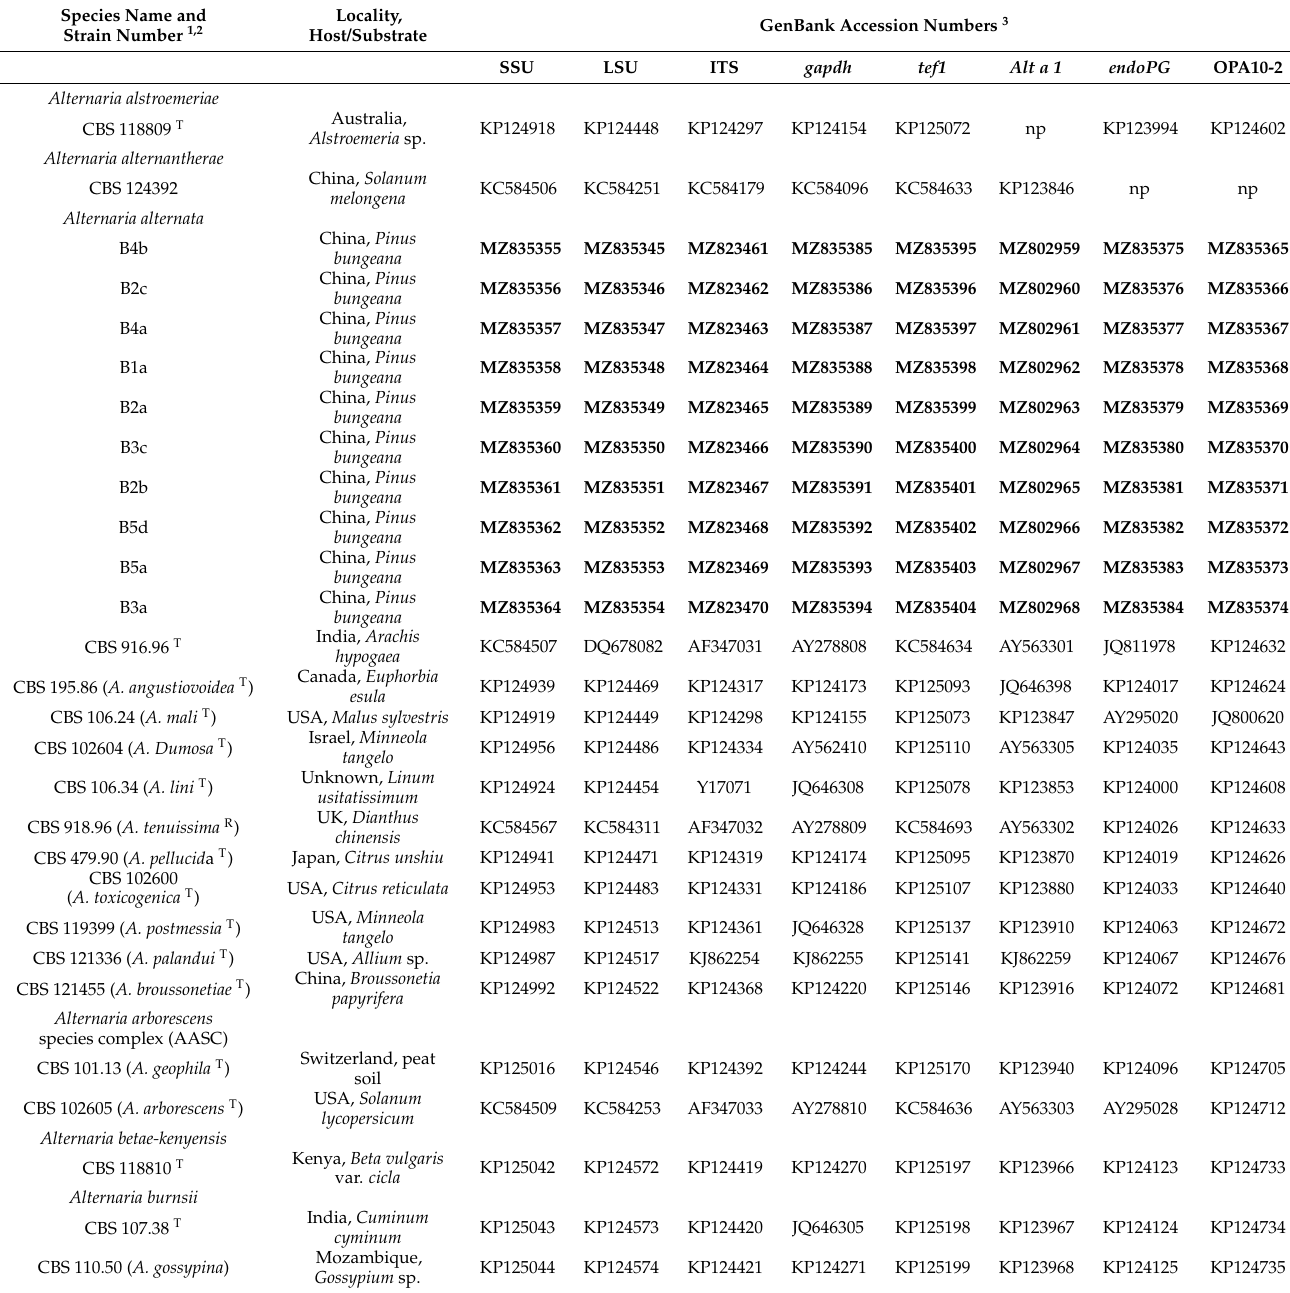
Table 2. Descriptions and sequence accession numbers obtained from GenBank of Alternaria spp. used in the phylogenetic